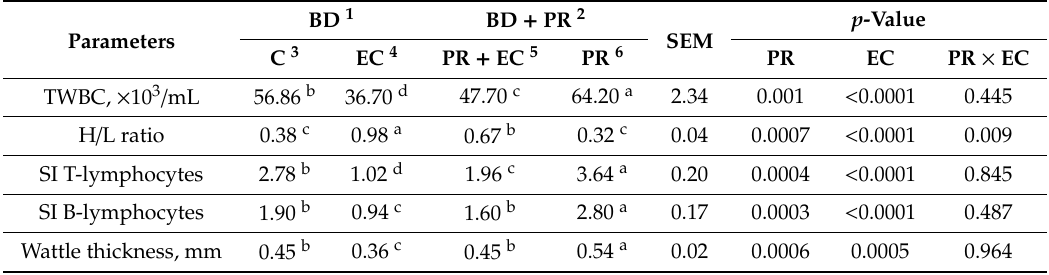
Table 4. The effects of dietary propolis supplementation and E. coli challenge on histomorphological measurements of small intestines in laying hens ( n = 5).